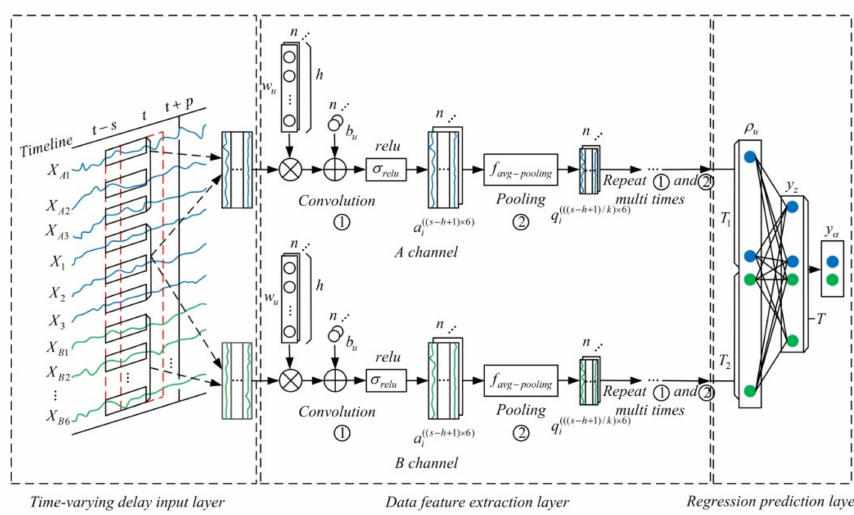
Figure 2. MWMC-CNN model